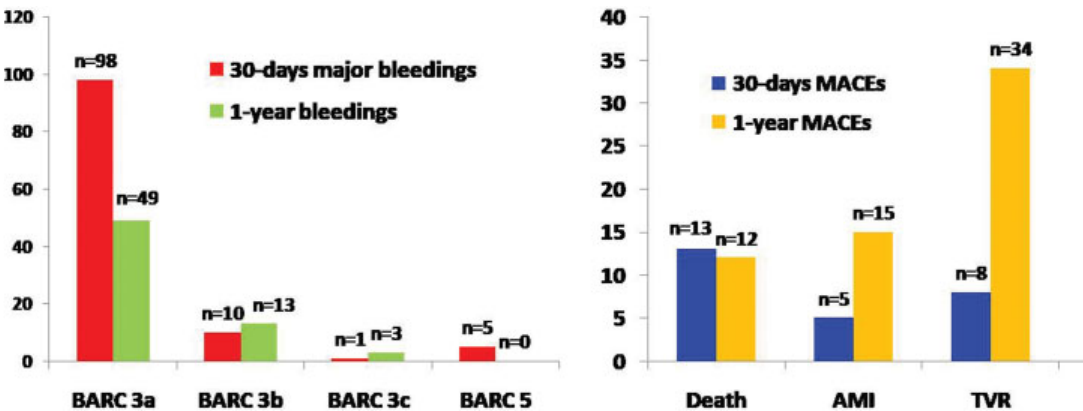
Fig. 1 Distribution of major bleeding events by BARC scale and MACE.